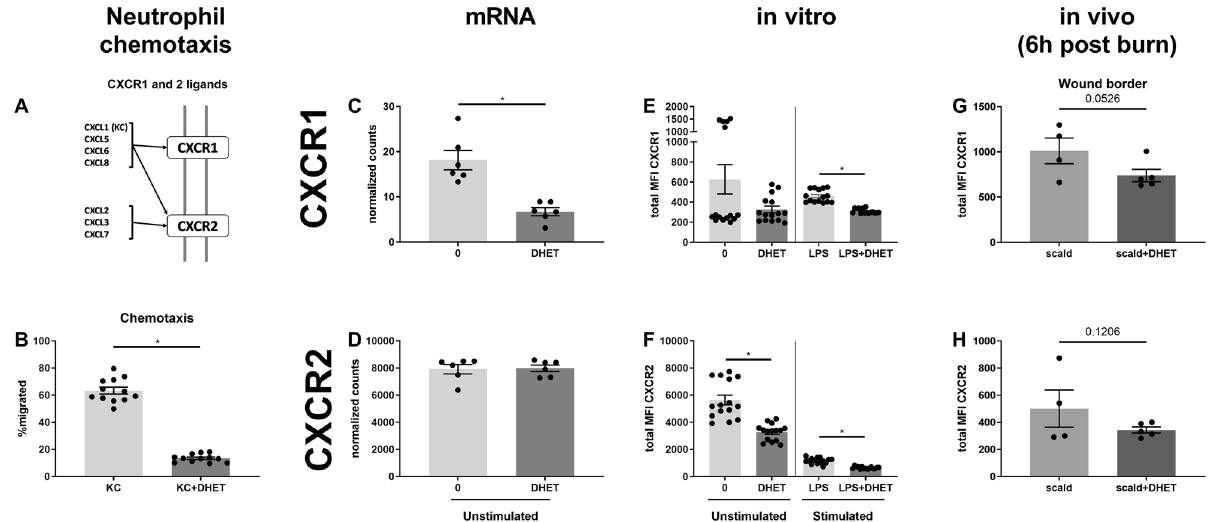
Figure 5. DHET impairs neutrophil migration in vitro in a CXCR1 and CXCR2 dependent way, and reduces their expression in an in vivo burn model. DHET impairs neutrophil expression of CXCR1 and 2 in vitro and in vivo, to which the strong chemoattractant chemokine (C-X-C motif) ligand 1 (CXCL1, or keratinocyte- derived chemokine: KC) binds. The migratory capability is therefore shown to be impaired. The chemokine CXCL1 (KC) is a strong chemoattractant for neutrophils and binds to CXCR1 and 2 ( A ). 14,15-DHET impairs Keratinocyte-derived Cytokine (KC, CXCL1) driven neutrophil migration in vitro after 3 h. We performed a neutrophil chemotaxis assay with bone marrow cells from C57Bl/6 mice (n = 12/ group). After harvesting bone marrow, cells were incubated on top of a transwell plate in 14,15-DHET and 100 ng of CXCL1 (KC) was added. After 3 h all cells were harvested and labelled using flow cytometry. Neutrophils were identified as Ly6G positive cells. We divided the number of neutrophils from the bottom well by the number of all neutrophils to assess the percentage of migrated neutrophils ( B ). To assess whether DHET reduces CXCR1 and 2 expression under stimulated or non-stimulated conditions we performed mRNA sequencing on isolated neutrophils of female C57Bl/6 mice after being incubated with 14,15-DHET with or without LPS (n = 6/group) ( C , D ). Consecutively, the expression of CXCR1 and 2 was measured in vitro. Bone marrow was incubated overnight with or without 14,15-DHET and with and without LPS. The cells were then labelled and total expression of CXCR1 and 2 measured via flow cytometry ( E , F ). Lastly, a burn injury model was conducted, and male CD1 IGS mice were injected with 15 µg/kg body weight 14,15-DHET or PBS as control. After 6 h the mice were euthanized and the skin surrounding the wound borders was cut out and dissociated. The cell suspension was then labelled and analyzed to assess neutrophil CXCR1 and 2 expression as total MFI via flow cytometry ( G , H ). Data are expressed as means ± SEM. * p < 0.05. The figure contains graphical elements of the KEGG